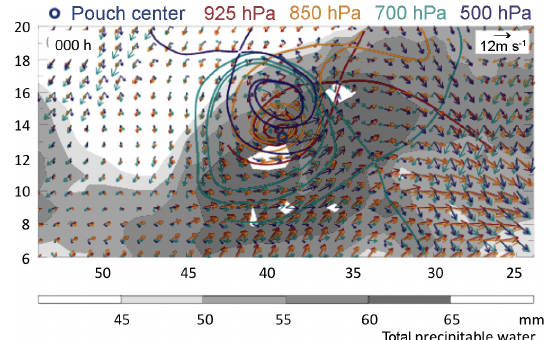
Figure 5. Dividing streamlines at 18:00UTC 2 September 2010 are shown for 500, 700, 850, and 925hPa, and are overlaid on co- moving wind vectors at each level and total precipitable